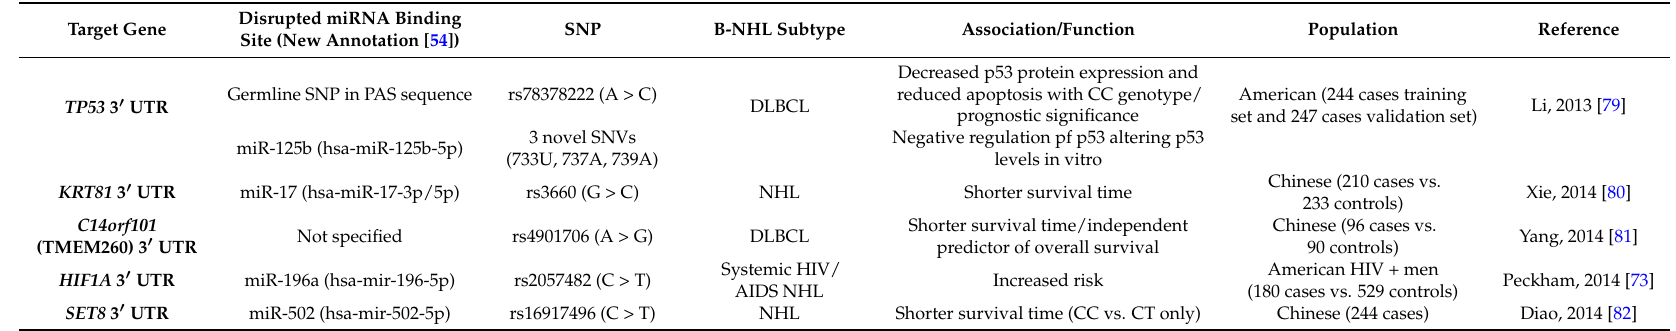
Table 3. A summary of single nucleotide polymorphisms and novel single nucleotide variants in the 3’UTRs of miRNA target genes and their association and function in different non-Hodgkin lymphoma (NHL) populations and subtypes, PAS, polyadenylation signal; SNV, single nucleotide